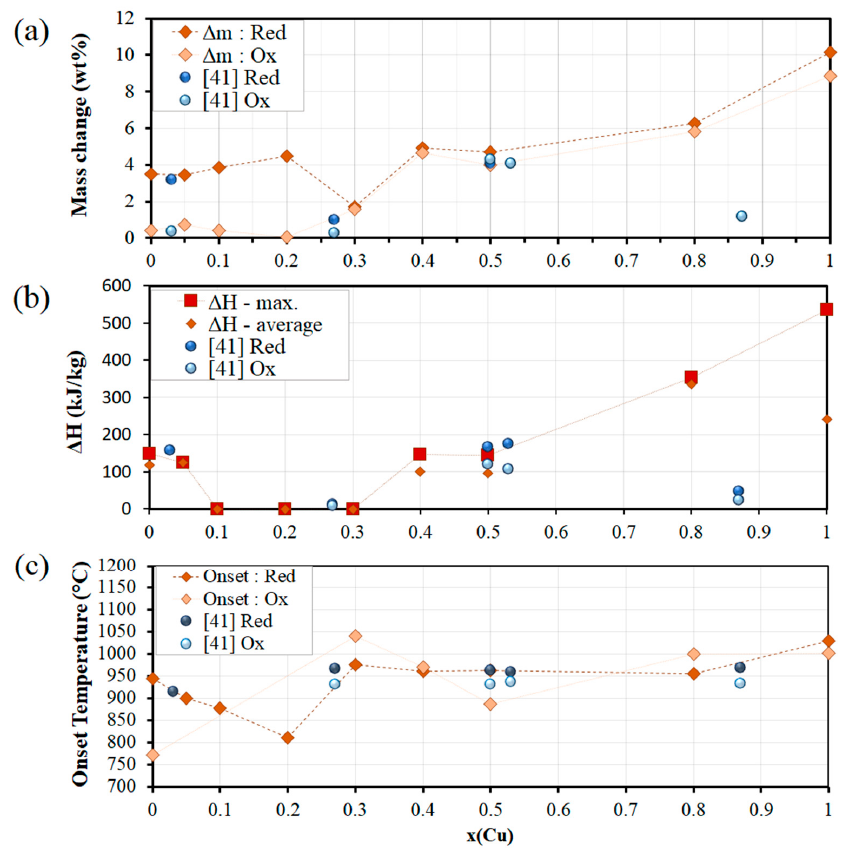
Figure 5. Mass variation (OSC), enthalpy change and onset temperatures of redox reactions measured for the Mn-Cu-O system.